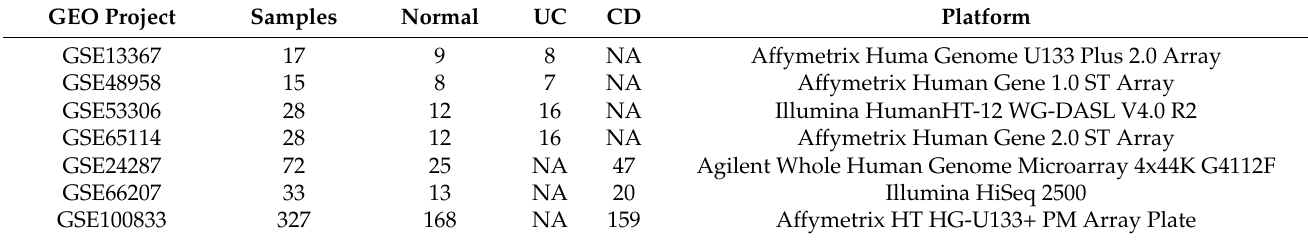
Table 1. Number of samples used in bioinformatics analysis. UC, ulcerative colitis; CD, Crohn’s disease; NA, not applicable. GEO